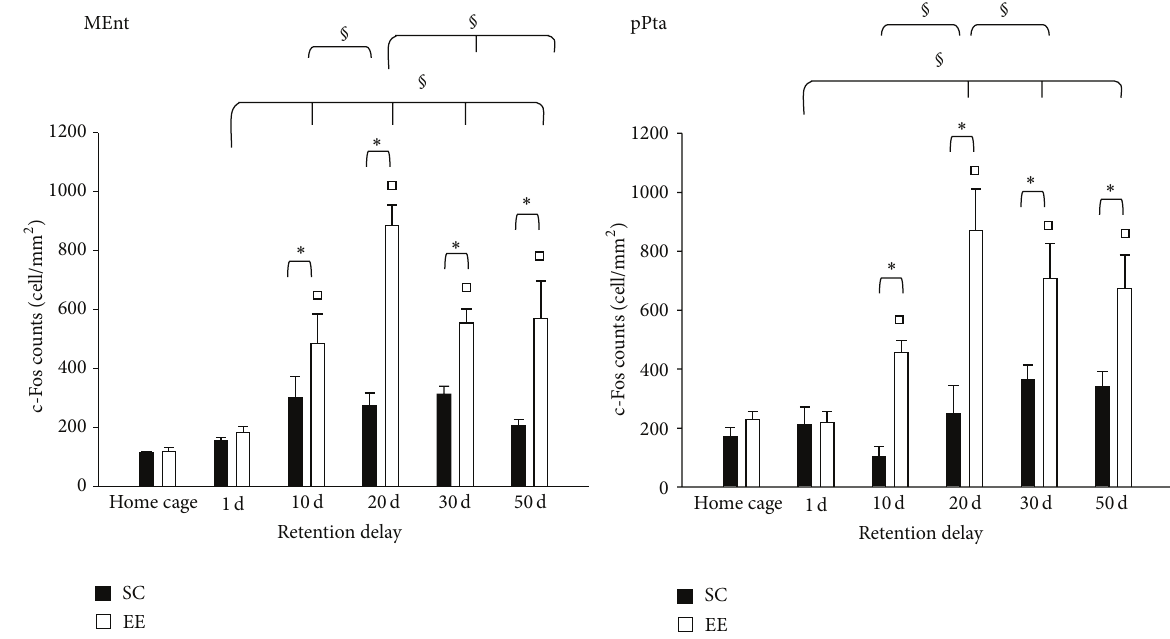
Figure 4: c-Fos protein expression in MEnt and pPta. MEnt : two-way ANOVA post hoc analysis Holm-Sidak method, HC-SC versus HC-EE 𝑃 = 0.914 ; statistical significance for EE versus HC-EE at 10, 20, 30 and 50 days. Statistical difference between EE and SC at 1 day, 𝑃 = 0.782 ; at 10, 20, 30 and 50 days, 𝑃 < 0.01 . Statistical difference within EE group were found between 1 day versus 10, 20, 30 and 50 days, and 20 days versus 10, 30 and 50 days, all 𝑃 values < 0.05. pPta : two-way ANOVA post hoc analysis Holm-Sidak method, HC-SC versus HC-EE 𝑃 = 0.497 ; statistical significance for EE versus HC-EE at 10, 20, 30 and 50 days, all 𝑃 values < 0.05. Statistical difference between EE and SC at 1 day, 𝑃 = 0.300 ; at 10 and 20 days, 𝑃 < 0.01 ; at 30 days, 𝑃 = 0.084 ; at 50 days, 𝑃 = 0.055 . Statistical difference within EE group were found between 1 day versus 20, 30 and 50 days, and 20 day versus 10 and 30 days, all 𝑃 values < 0.05. Statistical difference within SC group were found between 1 and 30 days, and 10 day and 30 days, all 𝑃 values < 0.05. ◼ Statistical significance between EE and HC-EE; ◻ statistical significance between SC and HC-SC; ∗ statistical significance between EE and SC; § = statistical significance for factor day within EE group; error bars =